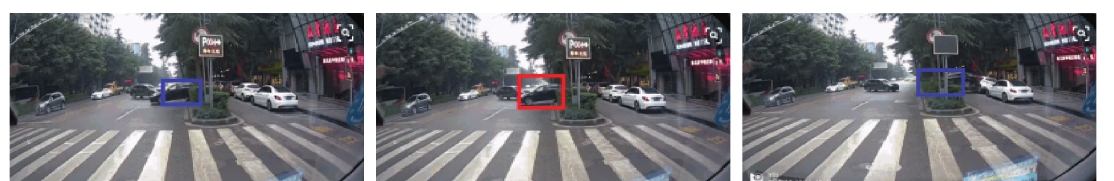
Figure 19: Convolutional neural network vehicle tracking.